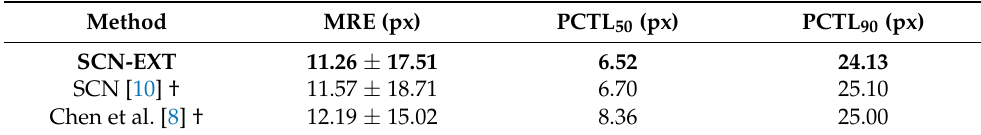
Table 6. Effectiveness of the better cephalometric landmark detection methods on the private AUDAX database. The column MRE denotes the mean and standard deviation of the radial error, while columns PCTL 50 and PCTL 90 denote the 50th (i.e., median value) and 90th percentiles of the radial error, respectively. All values are in pixels.